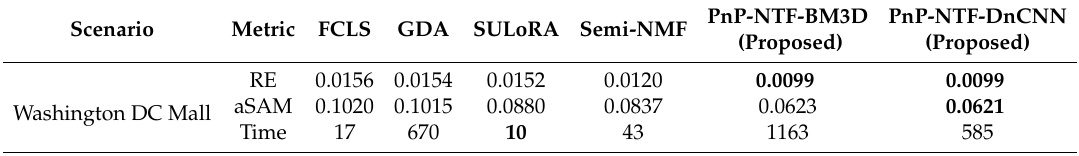
Table 8. Evaluation Results with the RE, aSAM and cost time (s) on the Washington DC Mall.